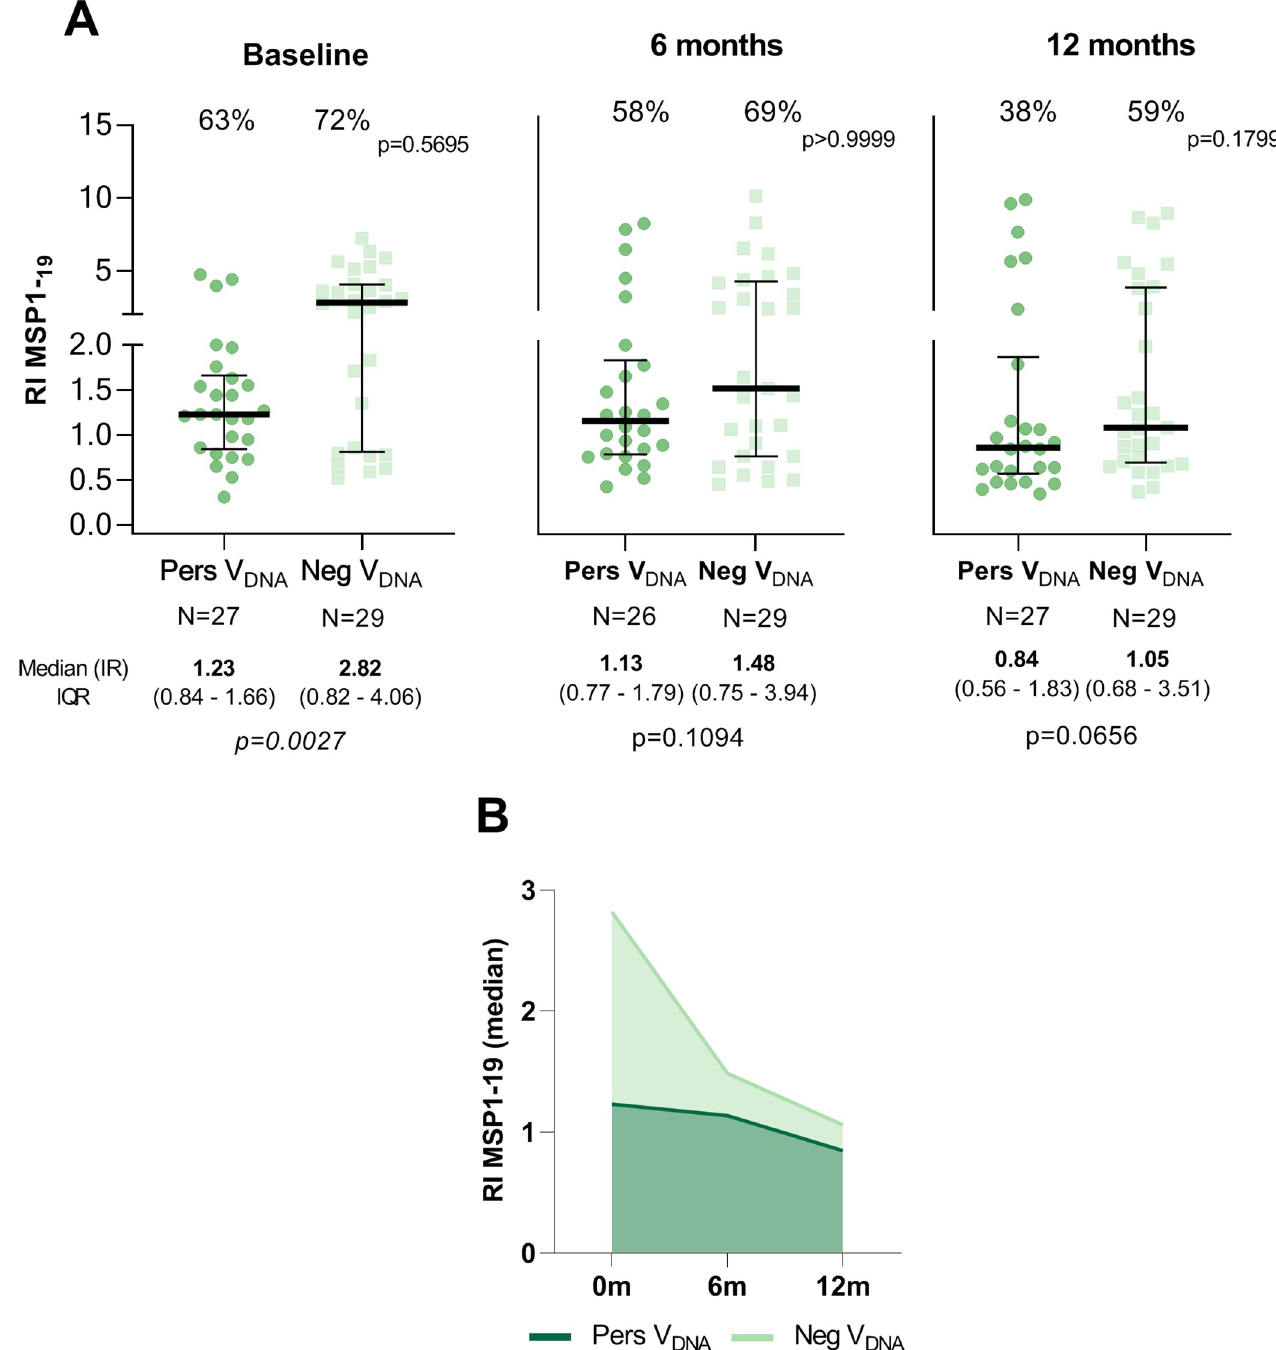
Fig 4. Profile of IgG antibody response against the 19-kDa C-terminal region of the Merozoite Surface Protein-1 (MSP1-19) in individuals with (PersV DNA ) or without (NegV DNA ) persistent viral DNA over the follow-up period. In A, results are shown by cross-sectional surveys (baseline, 6- and 12-month), with individual data points expressed as ELISA Reactivity Index (RI) and shown here as a scatter dot plots with lines showing the median with interquartile range (IQR). In B, medians of RIs overtime for each group. Numbers in the top and bottom of each graphic represent the proportion of responders (%) and median (RI) with IQR values, respectively; p-values for significant difference between groups were included and calculated as described in methods. Reactivity Index (RI) was calculated as described in methods and RI > 1 corresponded to an ELISA-positive response.